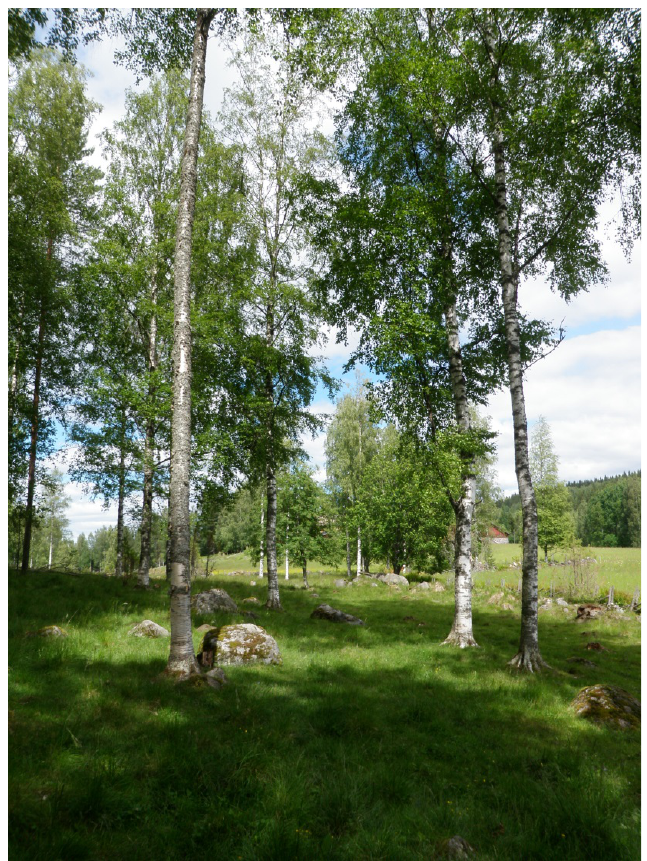
Figure 1: A sparsely wooded pasture is a typical traditional rural biotope type in Finland. Features that promote biodiversity include disturbances by grazing, heterogeneous tree structure, dead wood, rocks, animal dung, and small open meadow patches. On this particular site, historical land-use is reflected in visible remnants of slash-and-burn agriculture from early 20th century. These include a layer of coal within top soil, piles of stones that are removed from the cultivated area, and distinctive tree structure (birch regenerates spontaneously on burned ground; also, the oldest trees are of same age which indicates that the first tree generation established on open ground). Photo: Kaisa J.